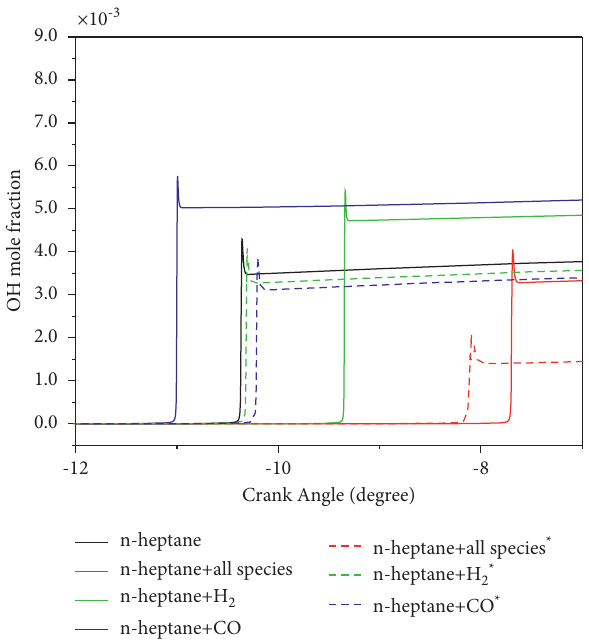
Figure 6: Distributions of OH radicals in different reforming